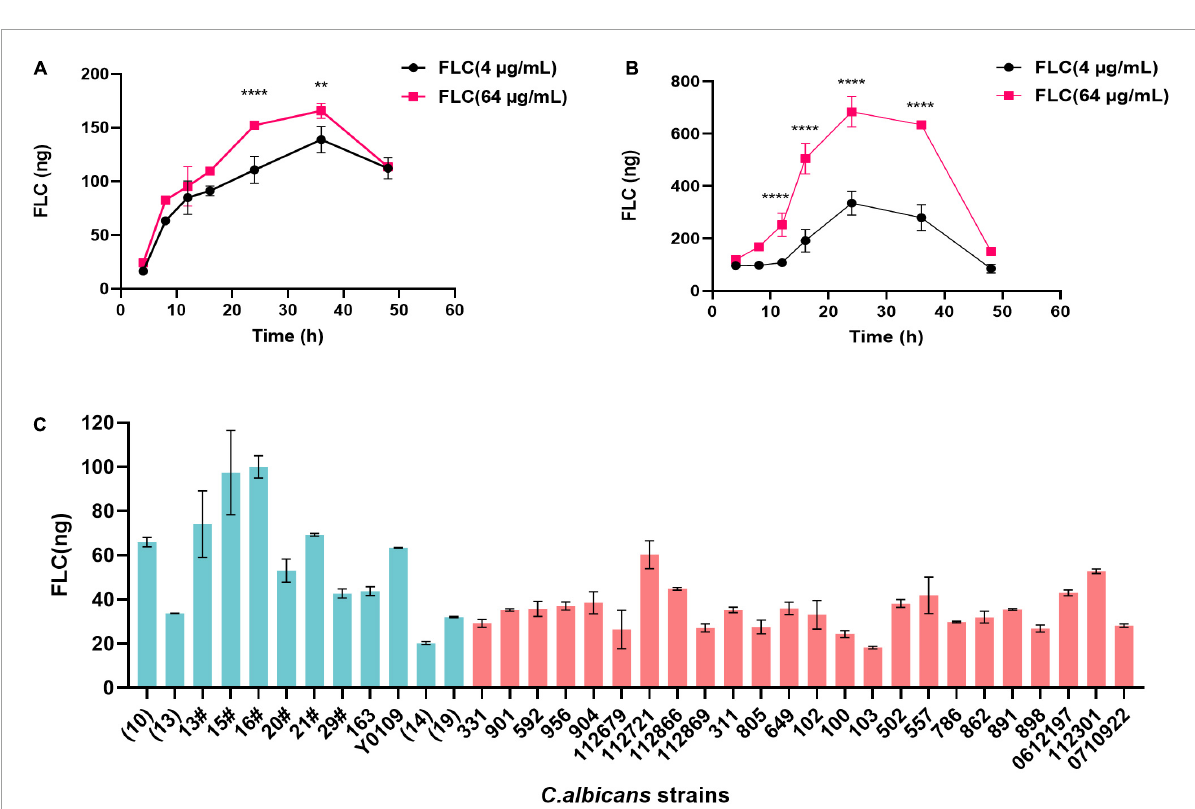
FIGURE4 Intracellular levels of FLC in 500.0 mg wet C. albicans samples. (A) Levels of FLC in samples derived from NO. 103 FLC-resistant C. albicans strain at different time points. (B) Levels of FLC in samples derived from NO. 100 FLC-resistant C. albicans strain at different time points. (C) Levels of FLC in C. albicans samples after 1-h incubation with 1 µ g/mL FLC. The green columns represent FLC-sensitive C. albicans strains, and the red columns represent FLC-resistant C. albicans strains. Data are mean ± SD from triplicates of one representative experiment of